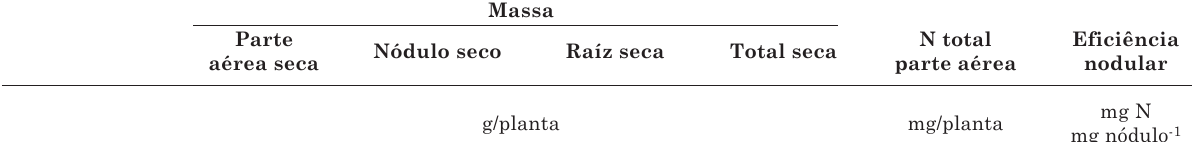
Quadro 3. massa de parte aérea, nódulos de raiz e total, acúmulo de nitrogênio na parte aérea e eficiência nodular de mucuna-anã e mucuna-cinza inoculadas com diferentes isolados de rizóbios, estirpe de referência br 2811, testemunha nitrogenada (com N e sem inoculação) e testemunha absoluta